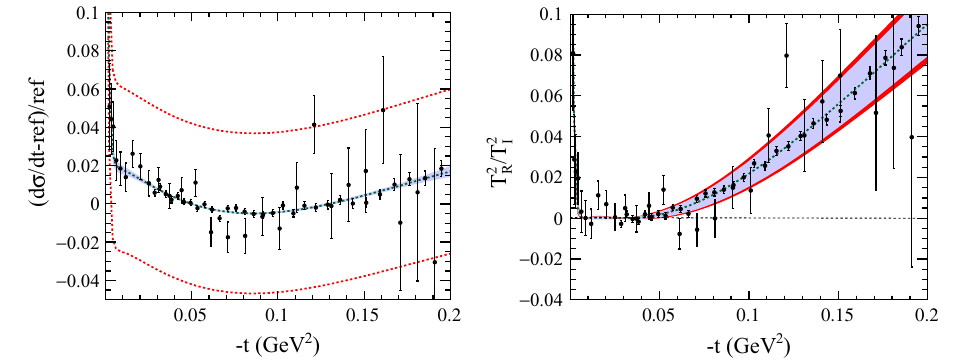
/ T 2 ratio T 2 , which exhibits information of a non-exponential behavior R I with advantages compared with the first plot, since σ is canceled, and with it most of normalization systematic error, and the second advan- tage is the clear indication of the structure of the real amplitude showing the position of its zero | t |